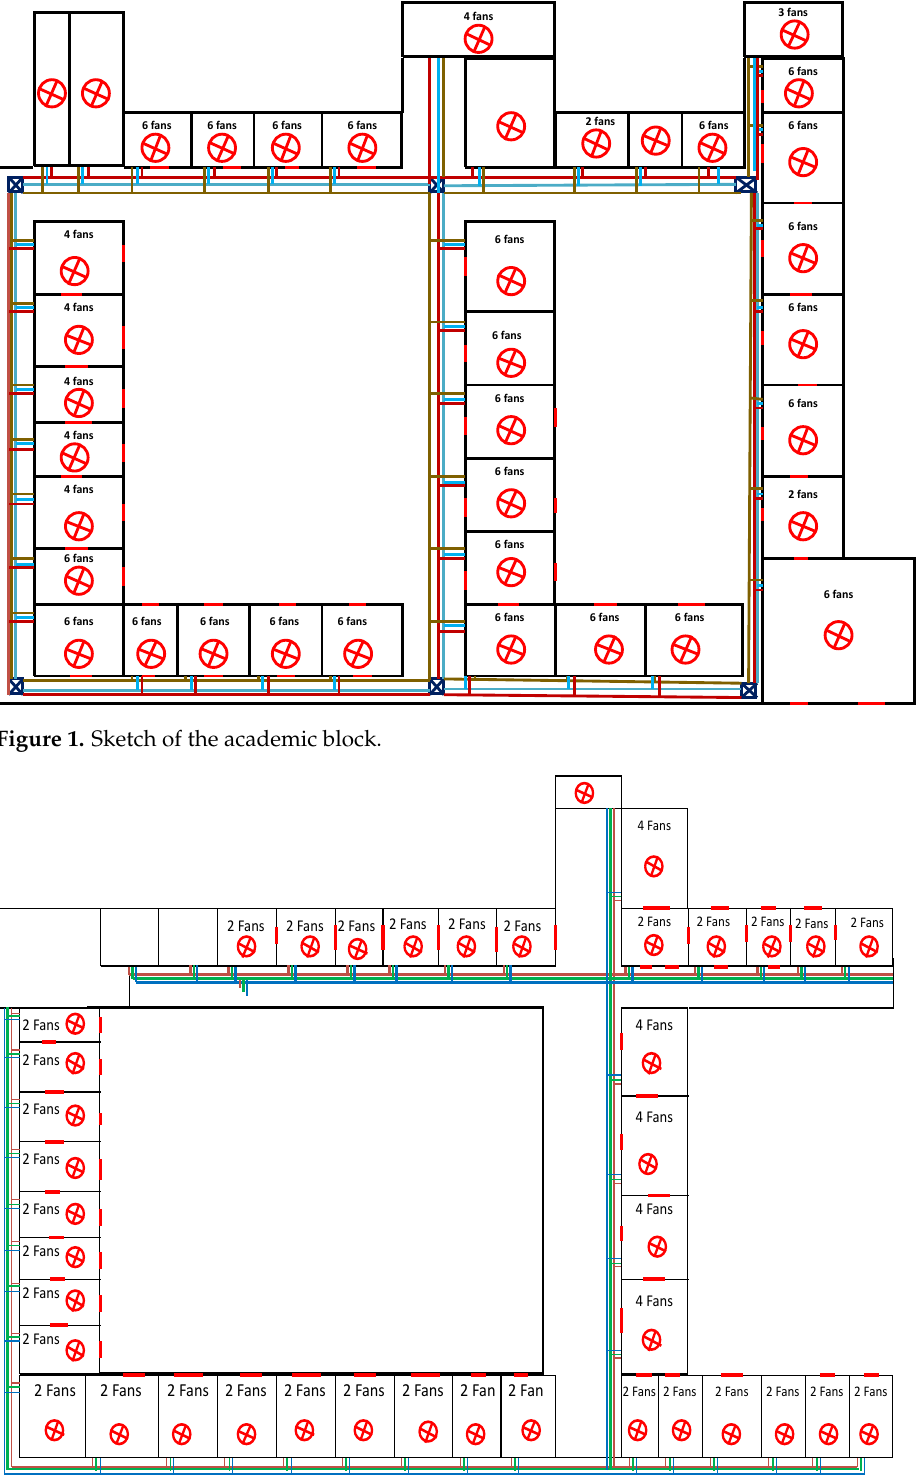
Figure 2. Sketch of the Allama Iqbal